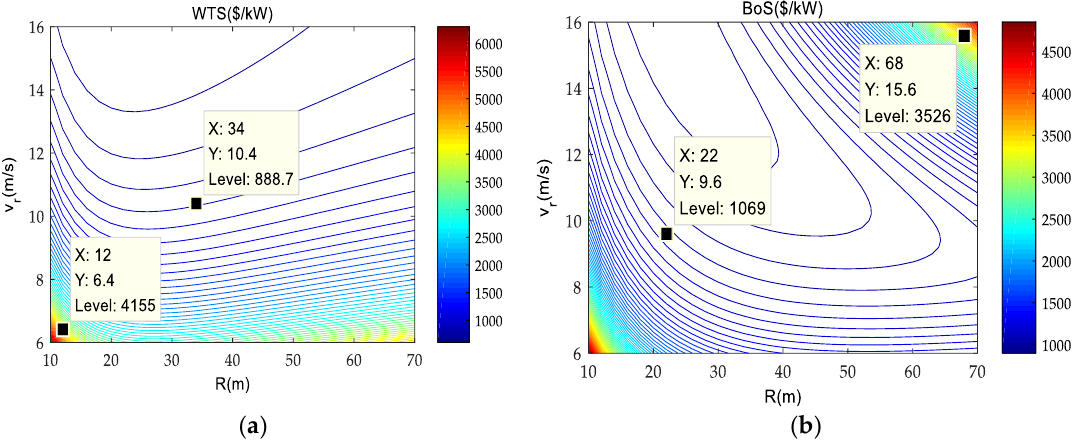
Figure 6. The two major component costs of offshore turbines versus the annual mean wind speeds and the shape factors: ( a ) the turbine system cost; ( b ) the station balance cost.